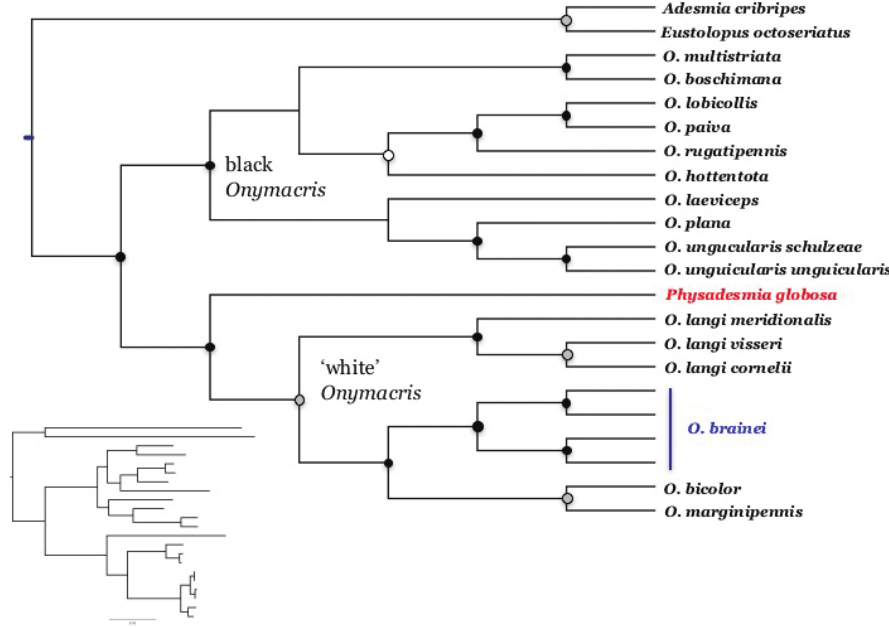
Figure 4. ML consensus topology of Onymacris , with bootstrap support indicated by black (> 95%), gray (> 90%), and white (> 70%) nodes. Inset at lower left is a ML tree showing branch